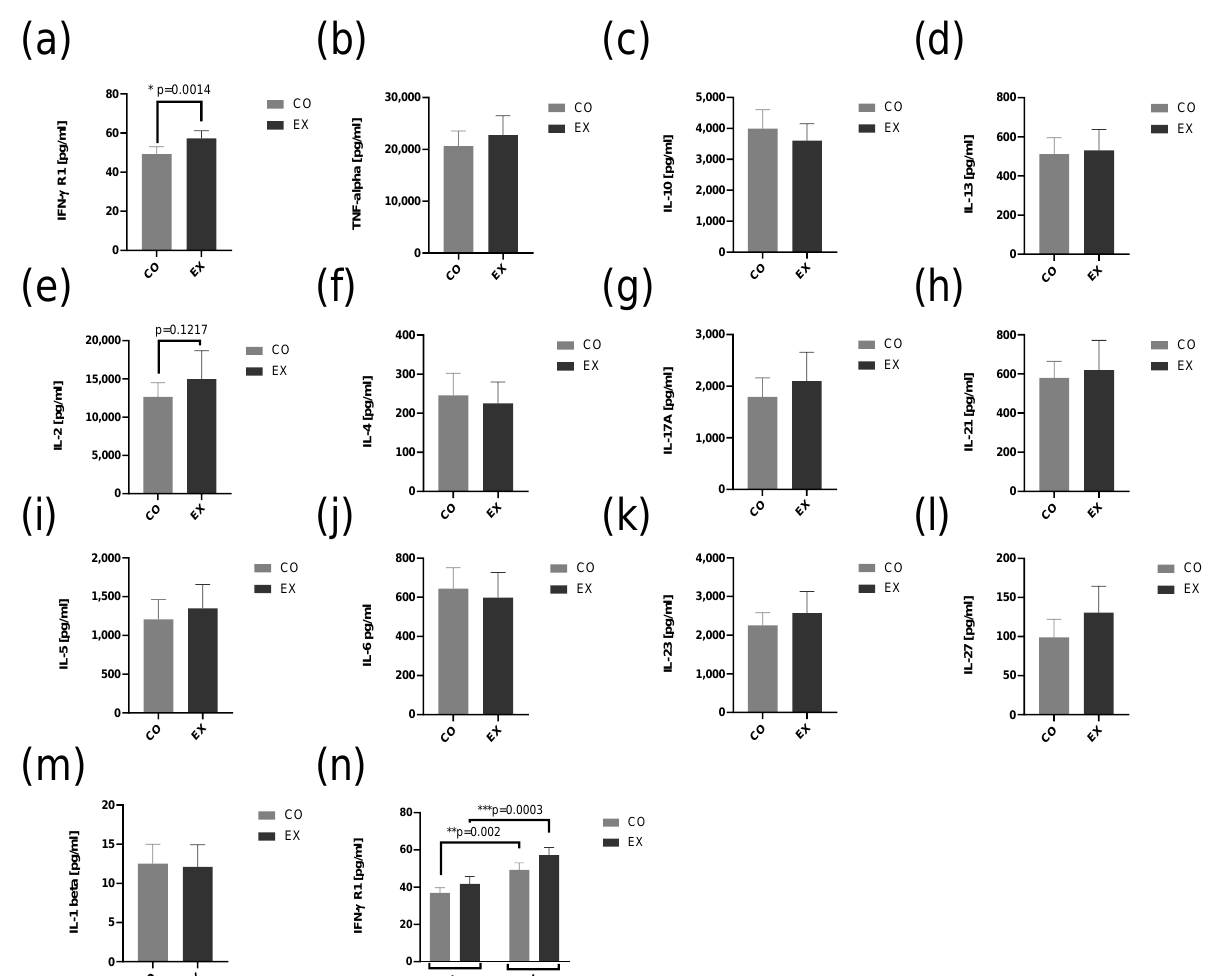
Figure 6. Interferon- γ receptor 1 ( a ) and cytokine ( b – m ) levels in supernatants after 48 h cell culture. Human CD4+ T cells from cohort 2 were activated supplemented by serum taken at resting conditions (CO) or after exercise (EX) and activated with anti-CD3/anti-CD28. IFN- γ R1 ( a ) and T cell interleukins TNF- α , IL-10, IL-13, IL-2, IL-4, IL-17A, IL-21, IL-5, IL-6, IL-23, IL-27, and IL-1 β were measured by commercial multiplex ELISA assays after 48 h cell culture for CO and EX condition. Beyond, IFN- γ R1 ( n ) was measured before and after 48 h of cell culture. All data are shown with mean ± SEM ( n = 7). Significance was determined by Student’s t -test for a-m. Significance was determined by two-way ANOVA followed by multiple comparison tests for n. * p < 0.05, ** p < 0.01, *** p < 0.001. ANOVA: analysis of the variance. CO: control group,